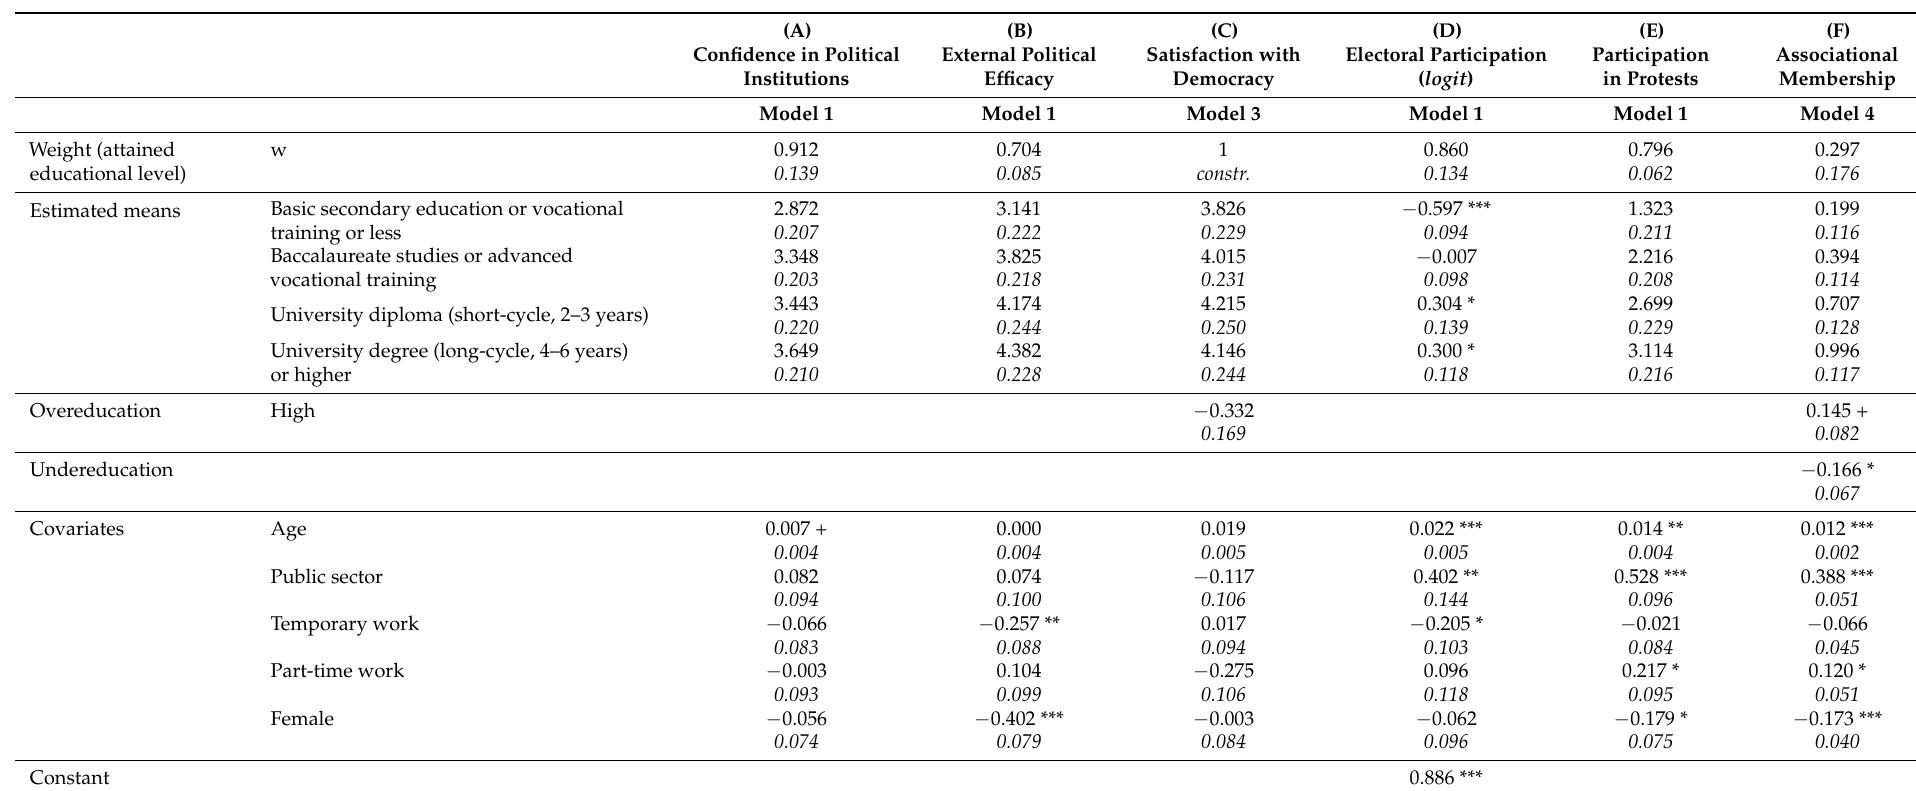
Table 2. DRM models assuming homogeneous effects of overeducation on attitudes towards the political system and political participation. Estimated parameters and standard errors from the selected